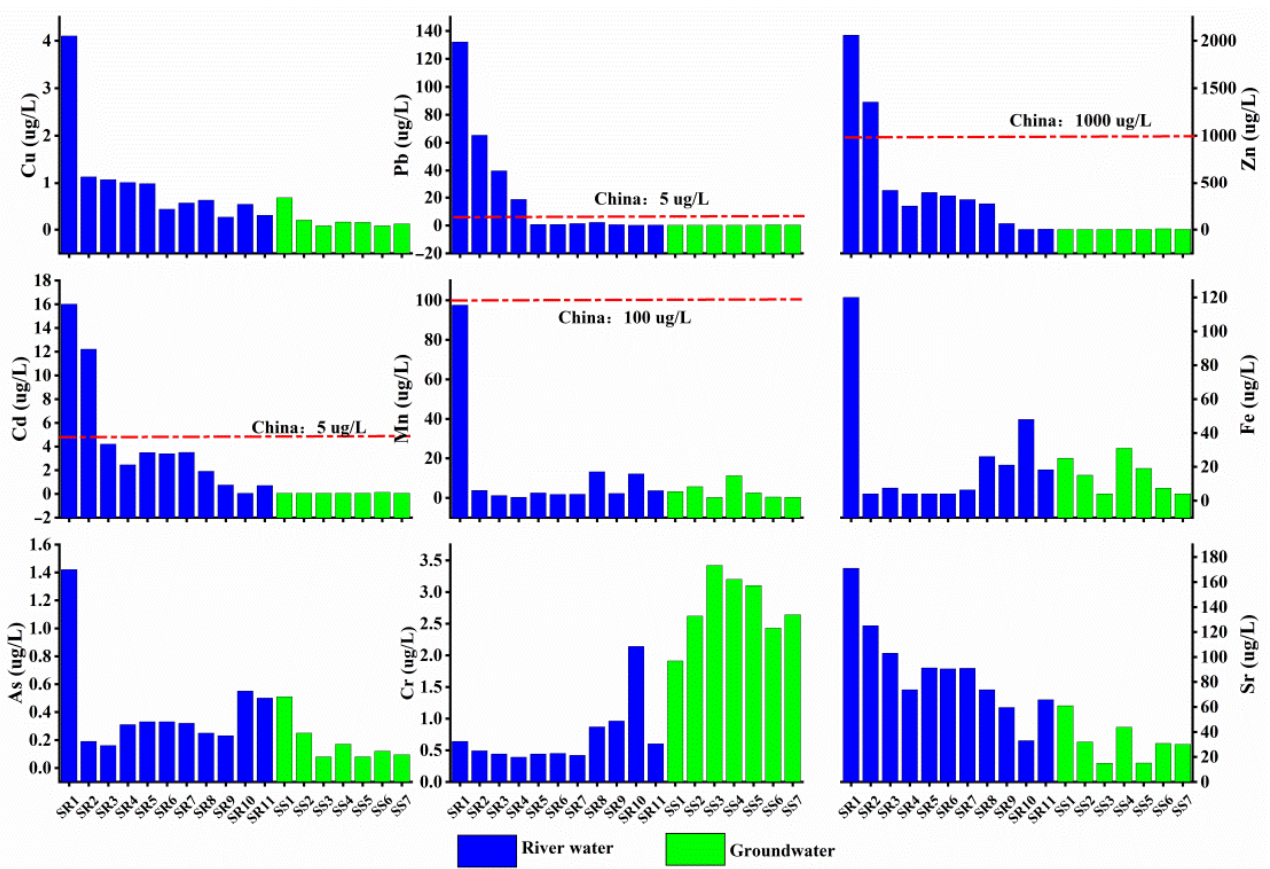
Figure 4. Distribution characteristics of heavy metals in river water and groundwater.